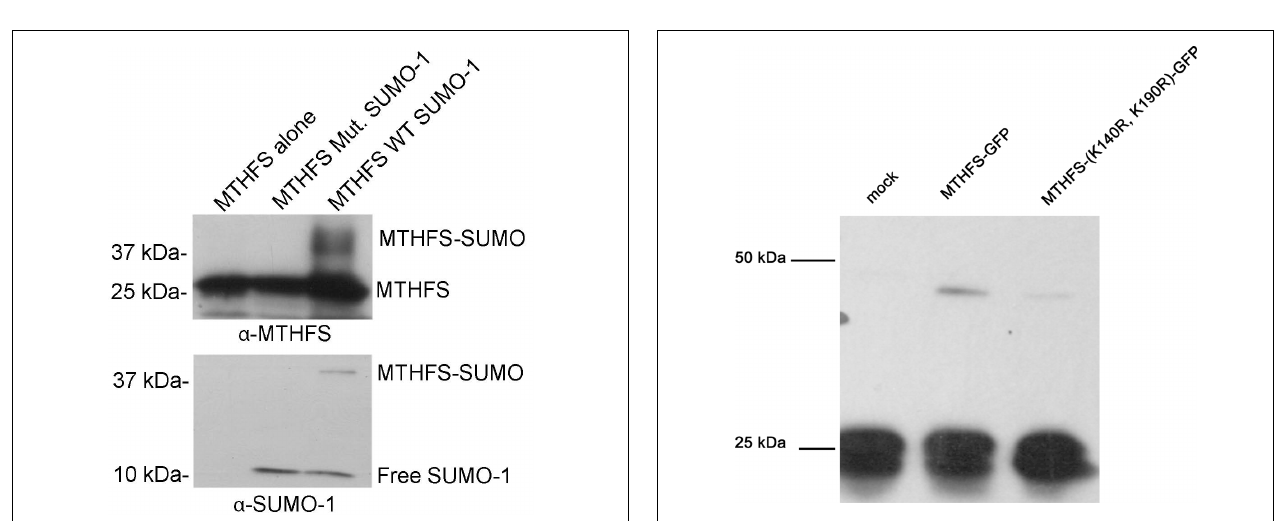
FIGURE 9 | MTHFS is sumoylated in vitro . Purified recombinant mouse MTHFS was SUMOylated using the SUMOlink SUMO-1 kit (Active Motif) according to manufacturer’s instructions. Membranes were probed with 1:5,000 dilution of sheep anti-mouse MTHFS antibody (described in section Materials and methods) or 1:10,000 α -SUMO1 antibody (ActiveMotif).